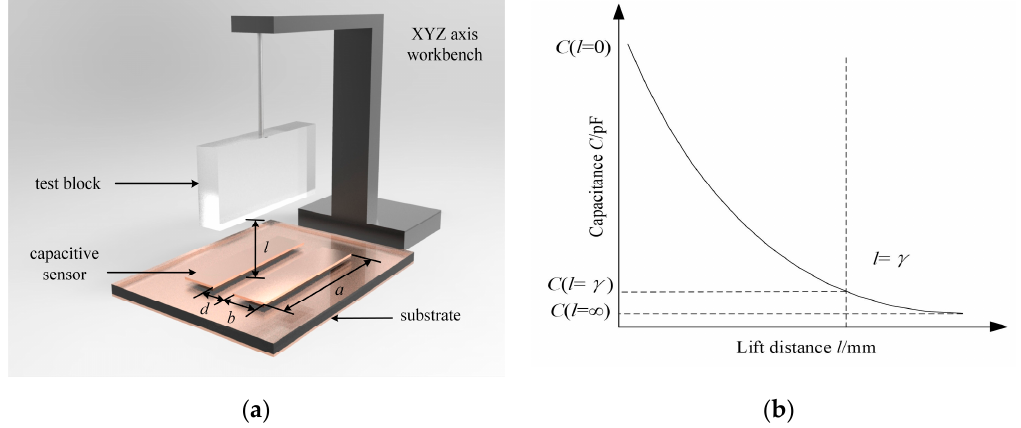
Figure 3. Penetration depth of the coplanar capacitive sensor: ( a ) Setup of the experiment; ( b ) the trend of the capacitance with different lift distances.